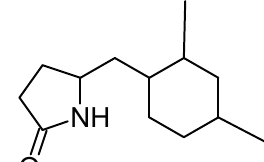
Figure 6. Chemical structure of 5-(2,4-dimethylbenzyl) pyrrolidin-2-one (DMBPO, 18